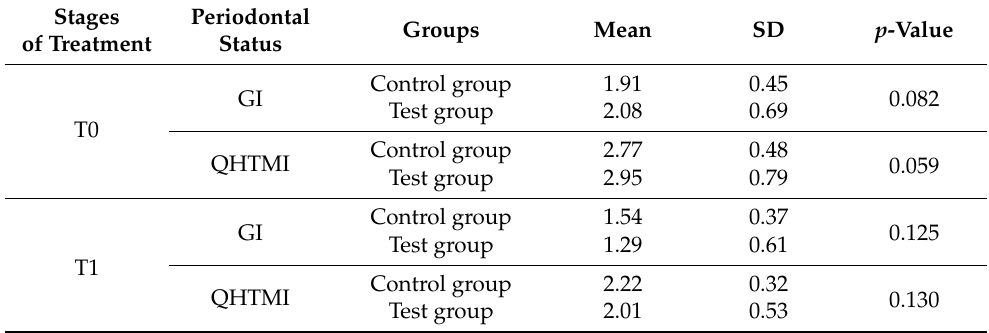
Table 3. Comparison of periodontal status between T0 and T1 stages of the treatment. Periodontal Stages Mean SD p -Value Group Status of Treatment T0 2.08 0.69 GI T1 1.28 0.61 Control group T0 2.95 0.79 QHTMI T1 2.01 0.53 T0 1.90 0.45 GI T1 1.54 0.37 Test group T0 2.77 0.47 QHTMI T1 2.23